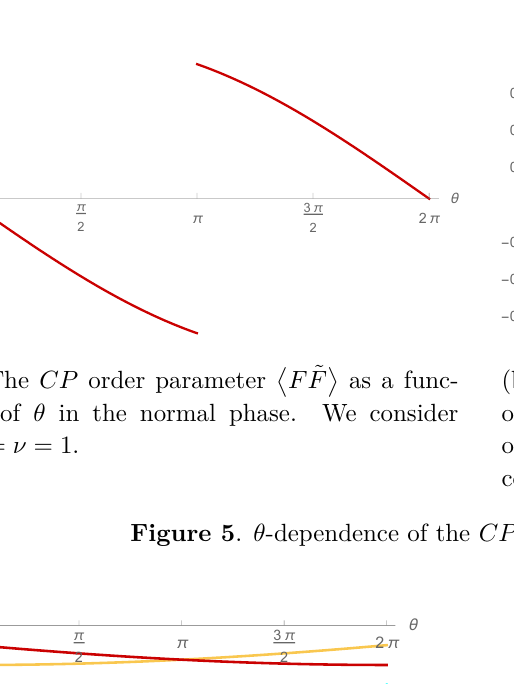
Figure 4 . Normalized critical chemical potential ( m π = ν = 1 ) above which the superfluid phase is realized as a function of θ for N = 3 . f